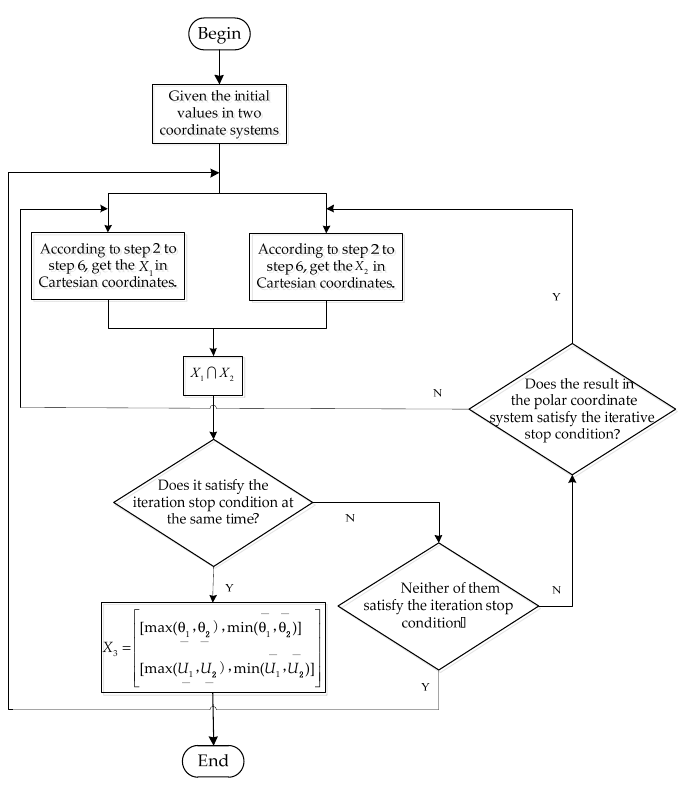
Figure 3. Calculation process of the mixed power flow.